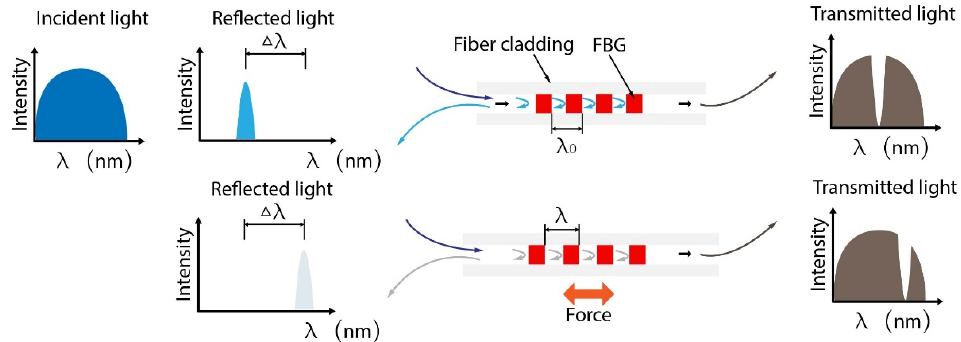
Figure 3. Mechanism of FBG-based force sensing. The FBG reflects the specific wavelength related to grating period, which can be changed with the axial strain. According to the physical characteristics and the reflected wavelength, the axis force can be